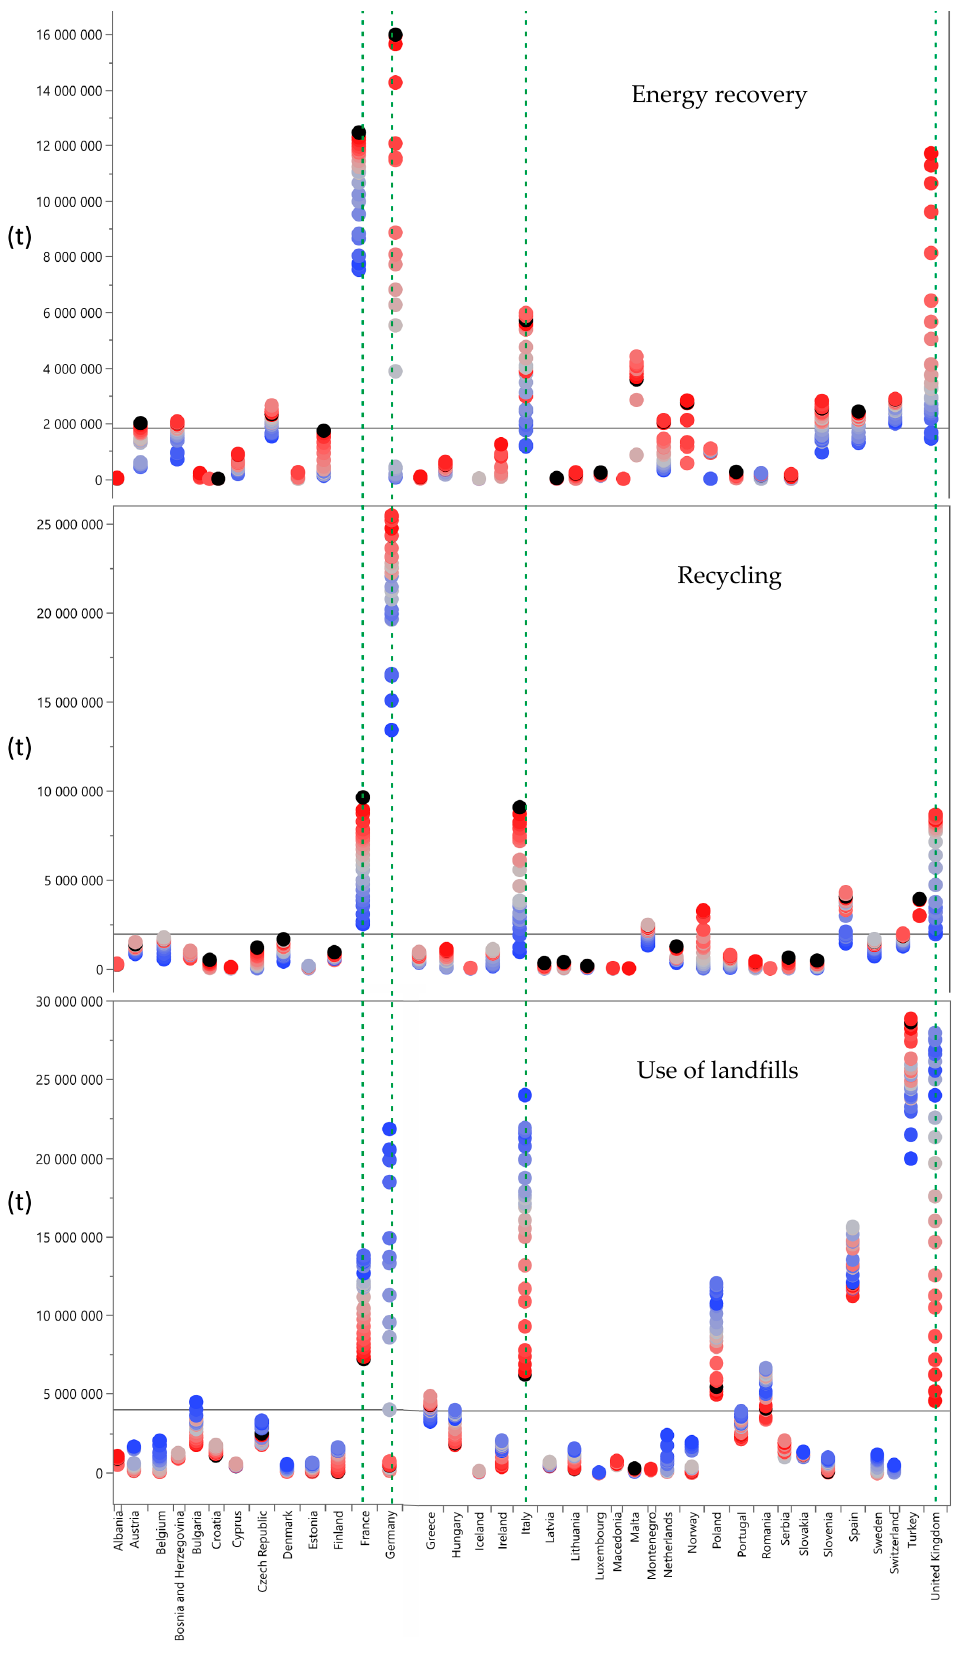
Figure 13. Methods of municipal waste management methods, in tons.